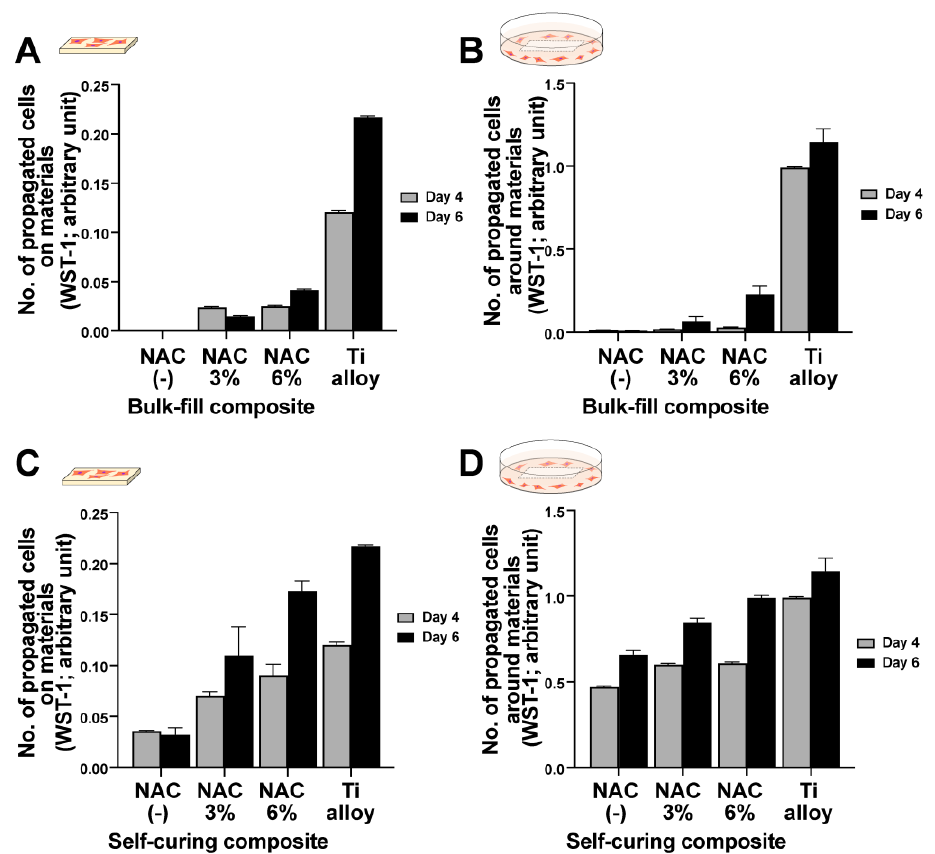
Figure 4. NAC-mediated improvements in material biocompatibility. WST-1 assays were performed on days four and six to quantify the number of cells proliferating on bulk-fill composite ( A ) and around bulk-fill composite ( B ). The number of cells proliferating on self-curing acrylic ( C ) and around self-curing acrylic ( D ).